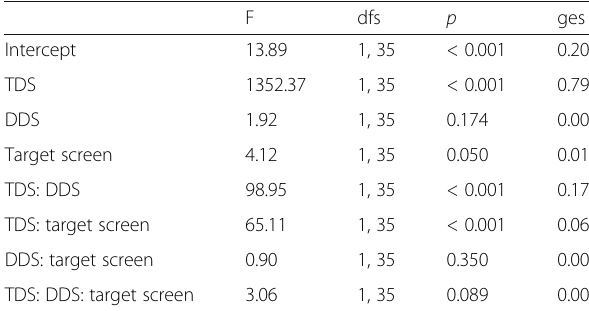
Table 2 ANOVA (type III) on averaged values of transformed reaction